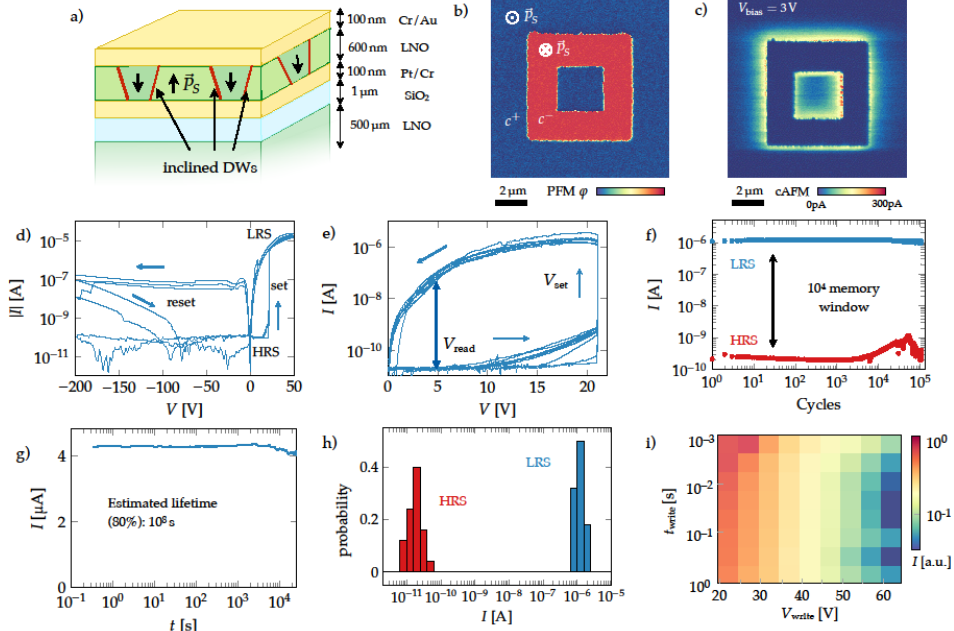
Figure 3. Investigation of the switching behavior, endurance, stability, and tunability of resistive switching of the Pt/LNO/Cr/Au stack with a contact area of 2000 μm 2 . ( a ) film stack configuration ( b ) PFM scan of